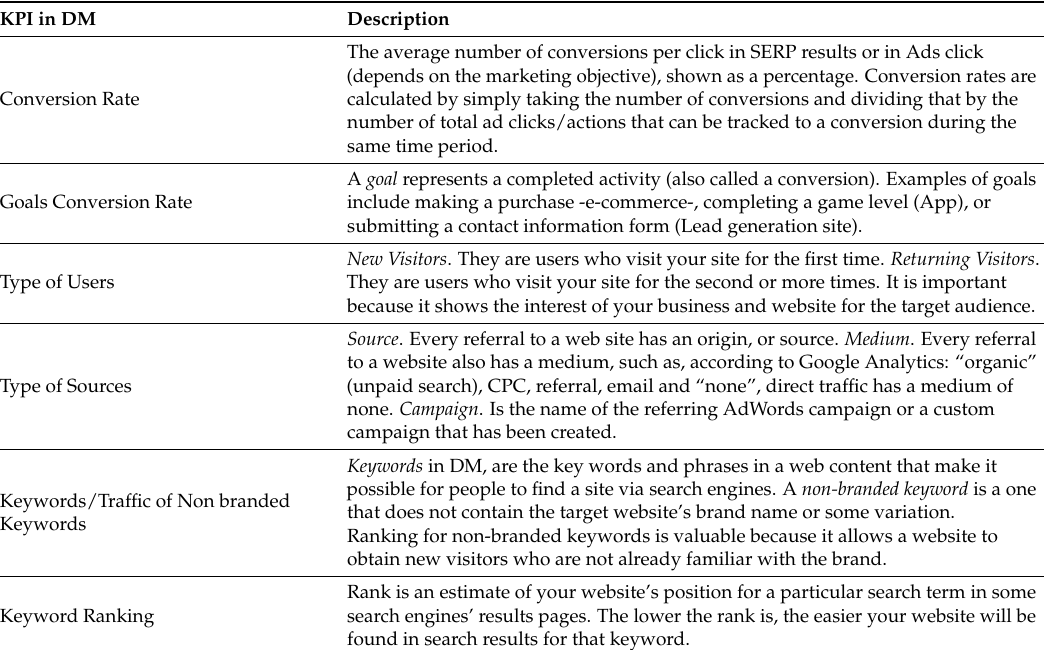
Table 8. Key Performance Indicators (KPIs) in